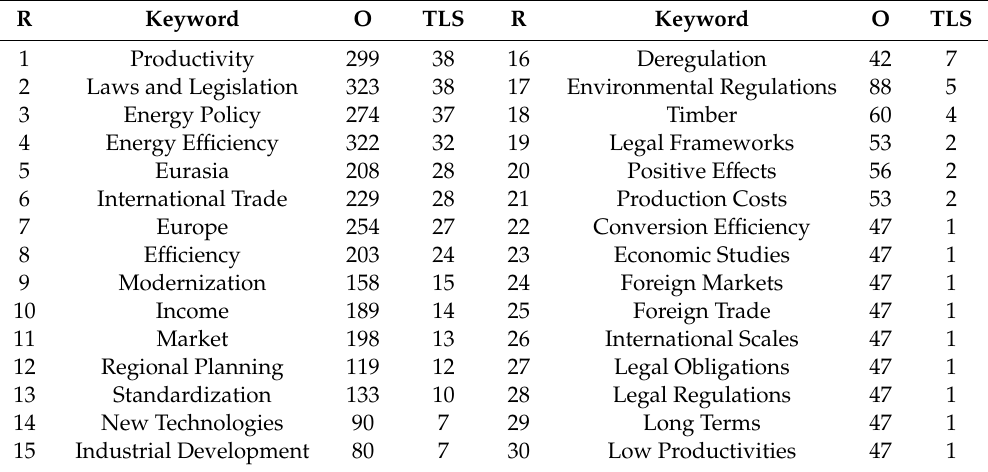
Table 11. Cluster 7. Top 30 keywords (1975–2019).